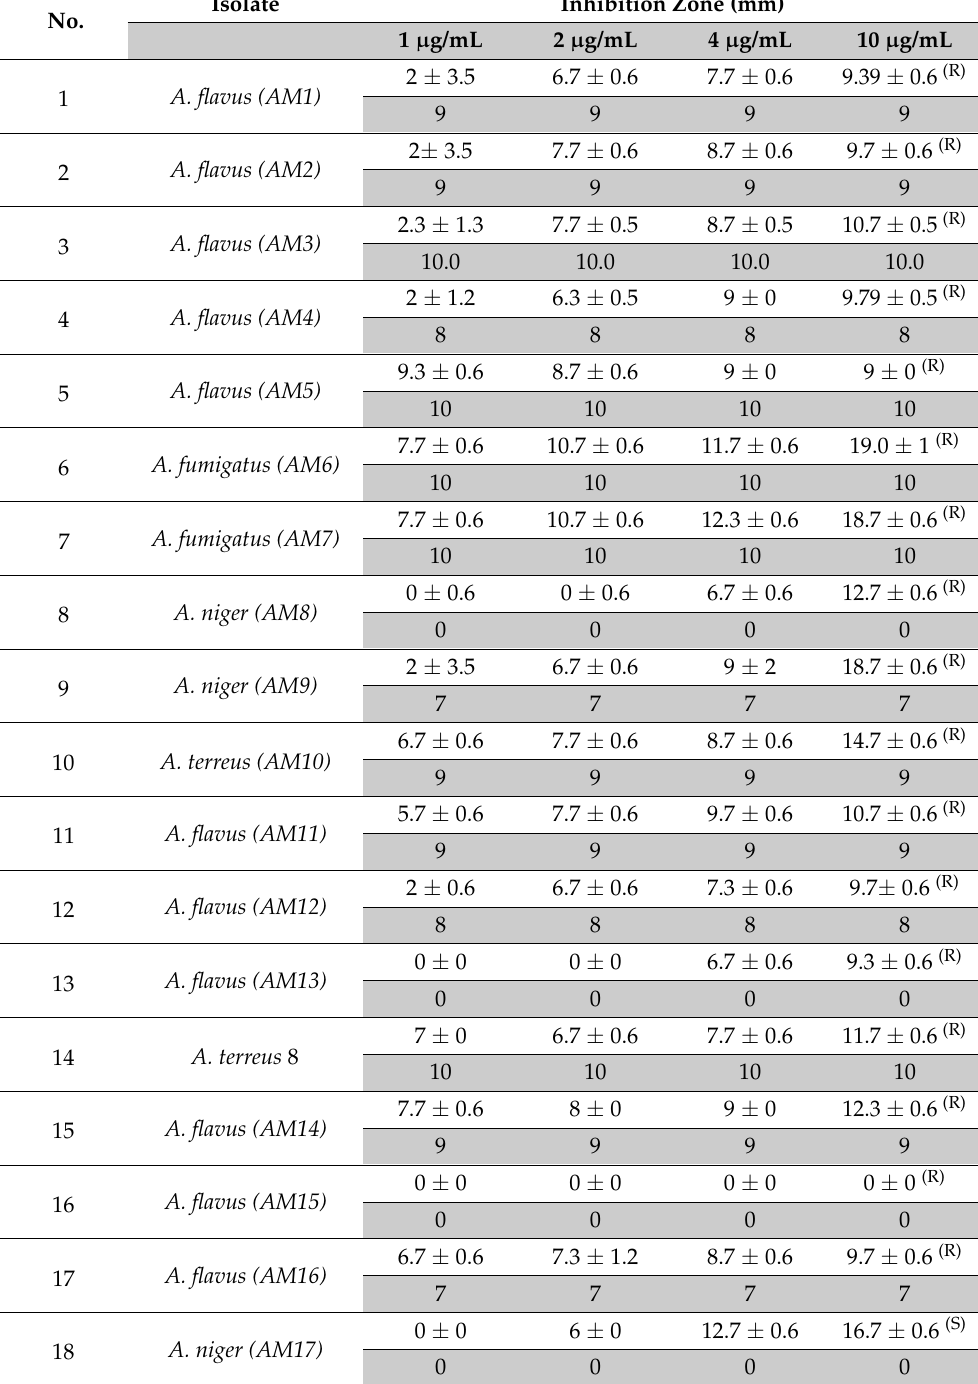
Table 2. Susceptibility of fungal species to different concentrations of Amphotericin B (disc method). Isolate Inhibition Zone No.